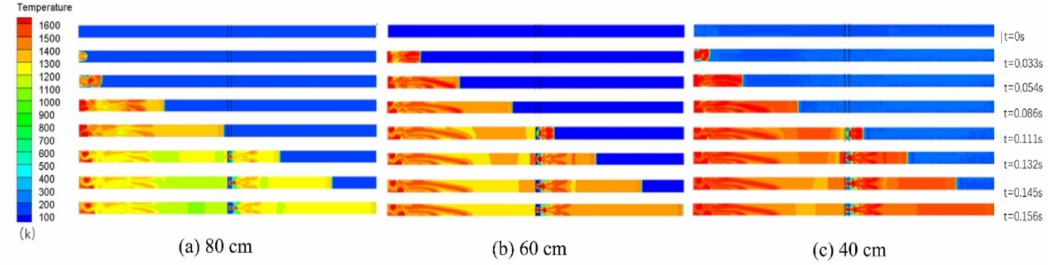
Figure 6. Comparison of temperature cloud of metal foam with different thicknesses.